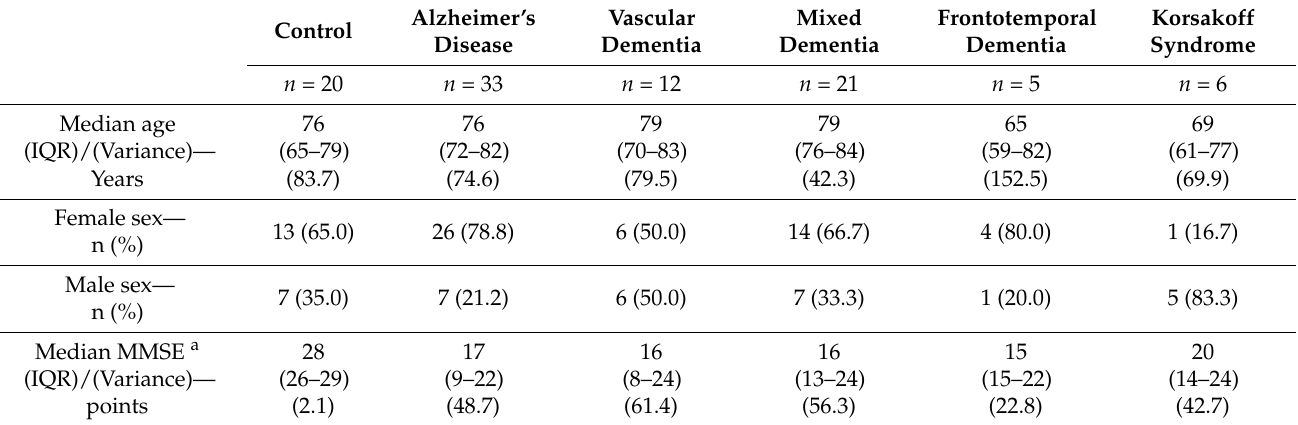
Table 1. Characteristics of the study population.